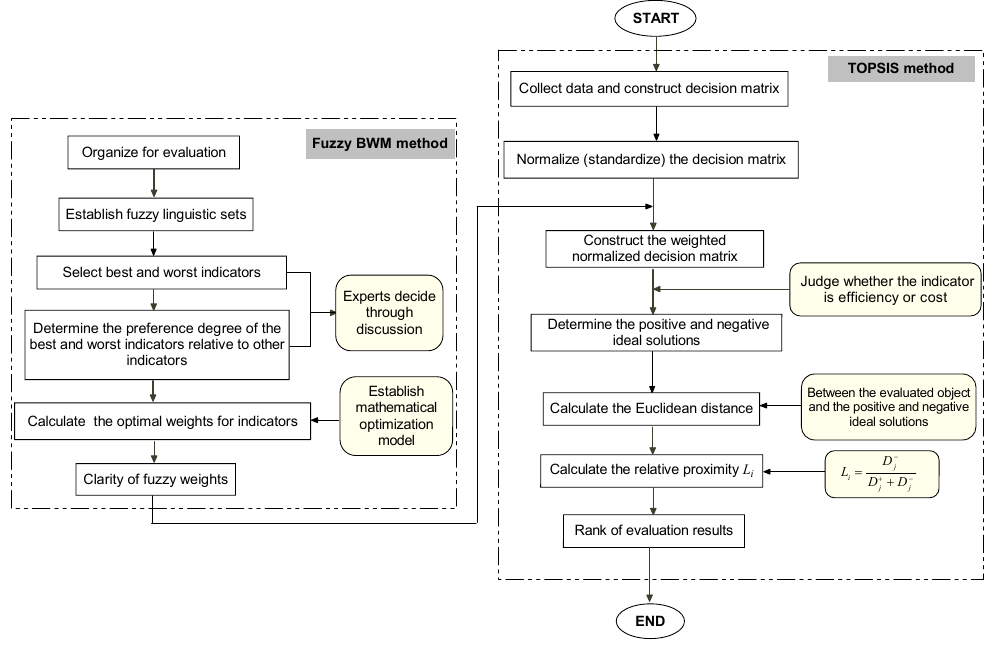
Figure 3. Fuzzy BWM-TOPSIS method framework. Table 1. Transformation rules of linguistic variables of decision